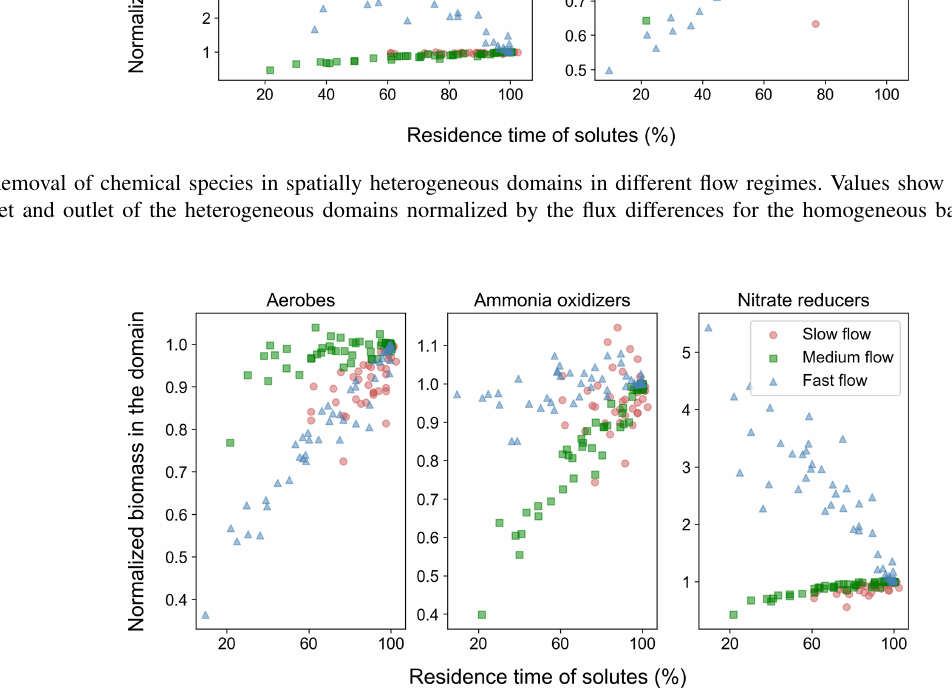
Figure 5. Biomass concentration of active immobile fraction of different species in spatially heterogeneous domains in different flow regimes. Shown volume-averaged values for the heterogeneous domains were normalized by values of the homogeneous base case of each flow regime.